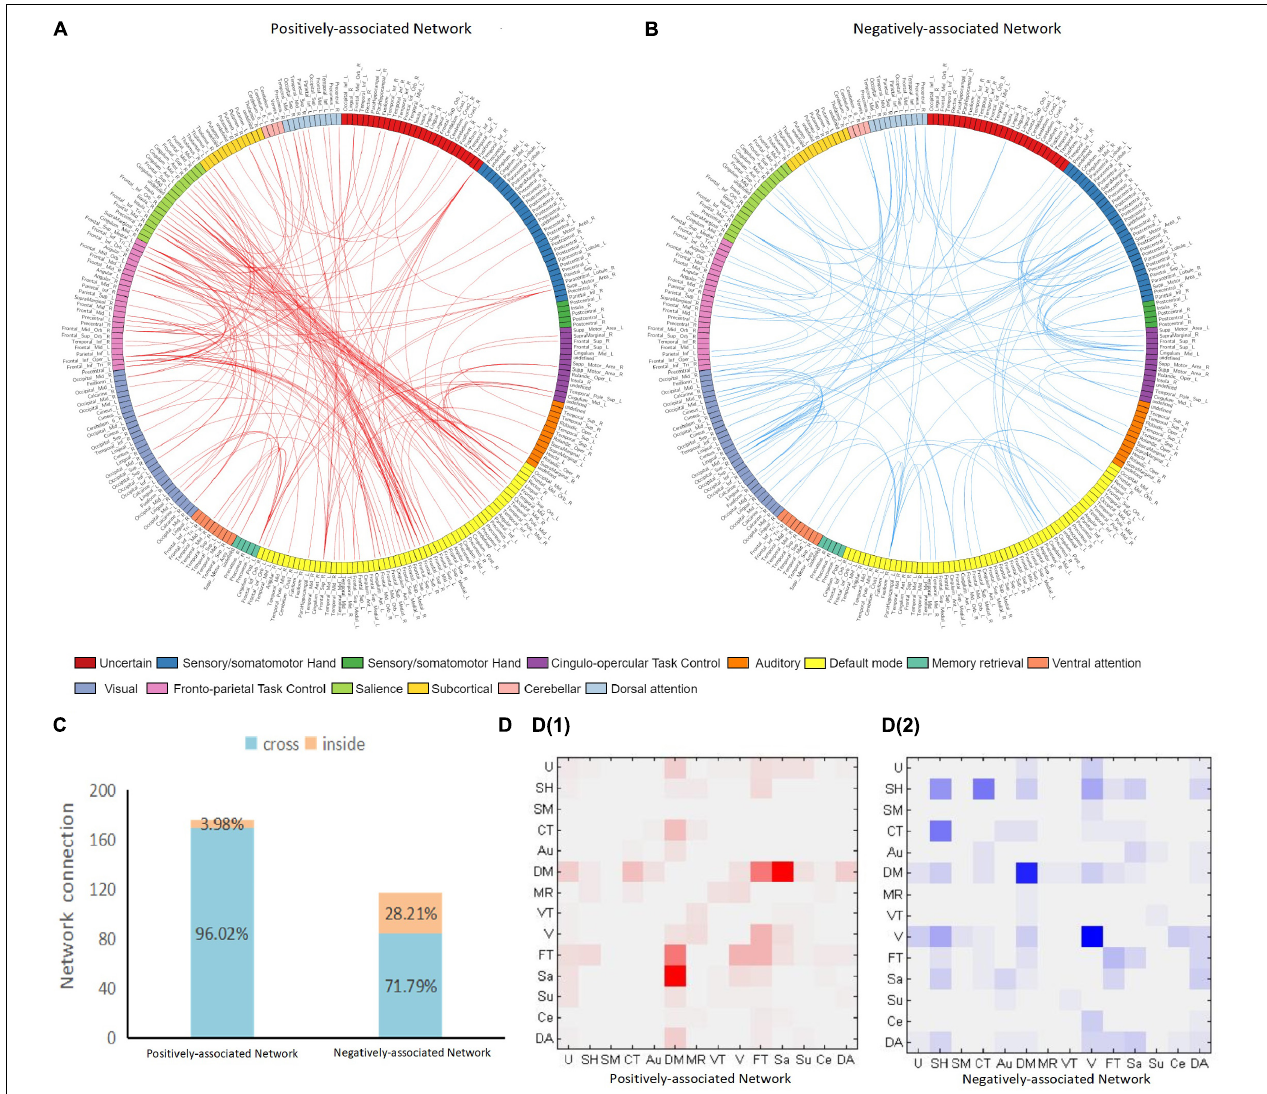
FIGURE 2 | Positive and negative network connection. Panel (A,B) plots show the distribution of positively and negatively associated networks across the 14 subnetworks. The 264 brain regions on the map are marked with different colors, each representing a subnetwork. The anatomical label of each brain region corresponds to the AAL90 atlas by MNI coordinates. Red edges indicate a positively associated network and blue edges indicate a negatively associated network. Panel (C) shows the proportion of cross-and intra-subnetwork connections. Panel (D) shows the connection matrix in each subnetwork. D1 is the positively associated network, while D2 is the negatively associated network. The positively associated network connections are focused on the DMN-SN and DMN-FPT networks. The negatively associated networks are focused on COTC-SMH network, DMN, and the visual network. U, uncertain; SH, sensory/somatomotor hand; SM, sensory/somatomotor mouth; CT, Cingulo-opercular task control; Au, auditory; DM, default mode; MR, memory retrieval; VT, ventral attention; V, visual; FT, fronto-parietal task control; Sa, salience; Su, subcortical; Ce, cerebellar; DA, dorsal